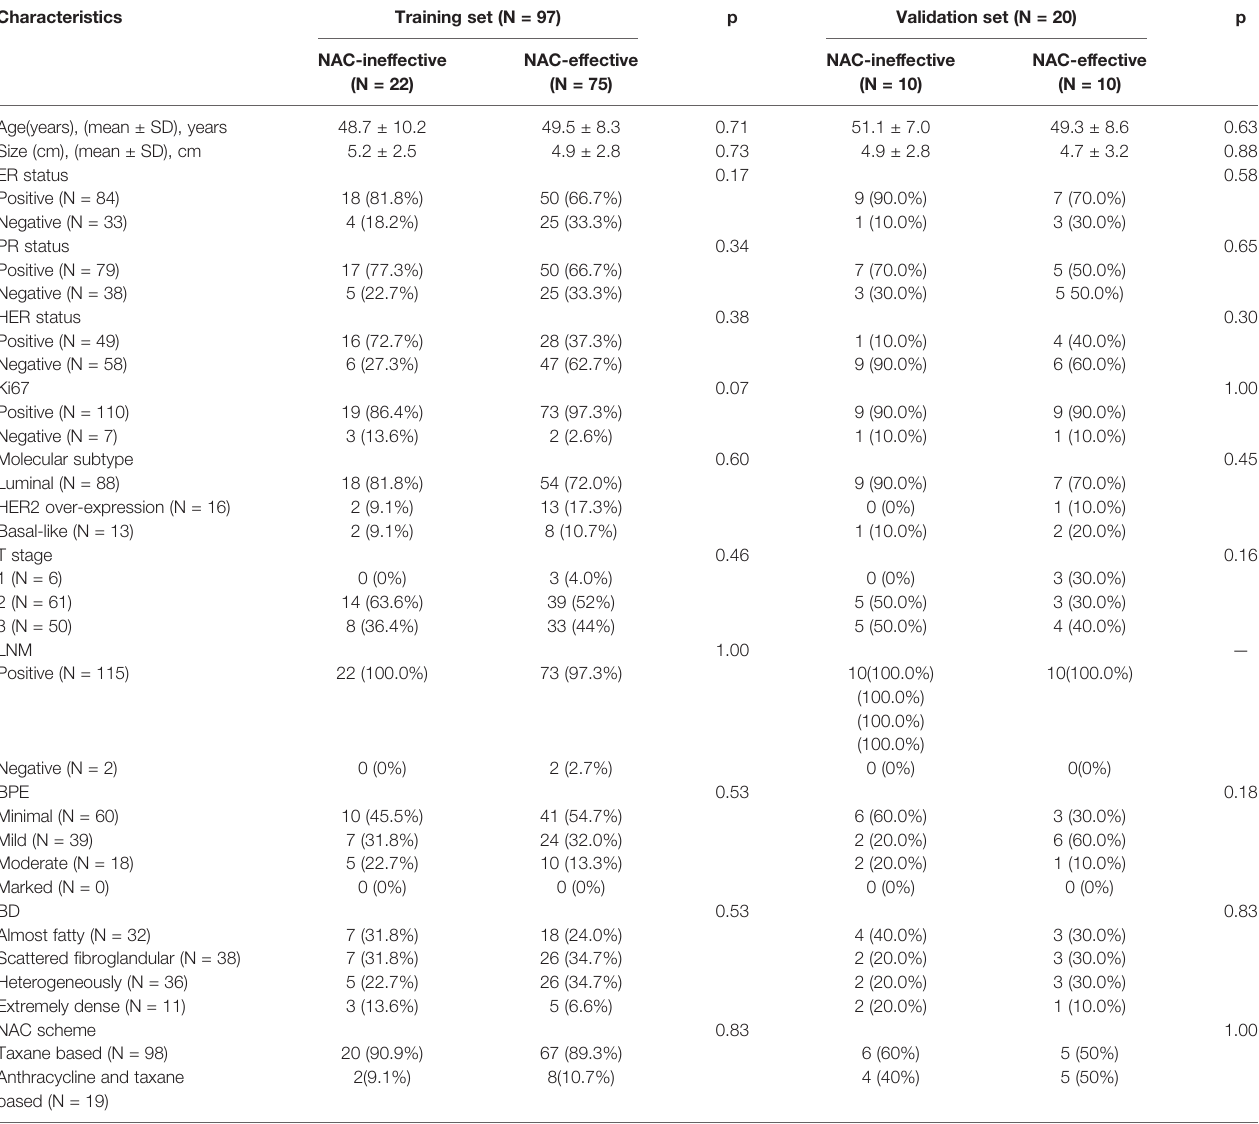
TABLE 1 | Clinical characteristics in the training and validation cohorts.